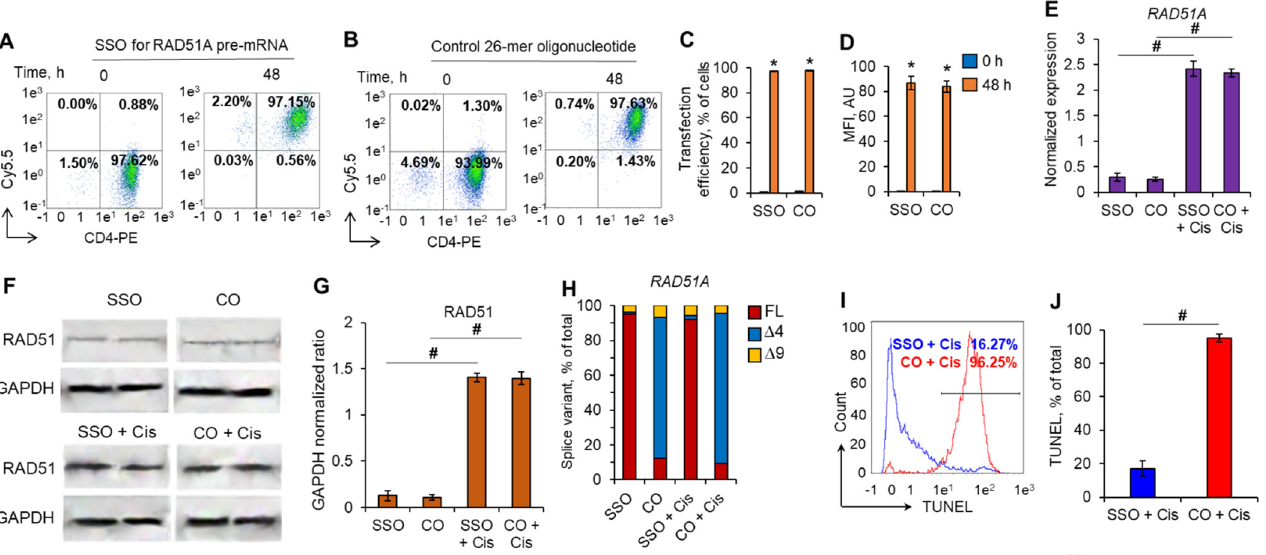
Figure 7. Modulation of RAD51A alternative splicing results in CD4 + T cell protection against cis- platin-induced apoptosis. Transfection efficiency of CD4 + T cells. Representative flow cytometry plots of cells transfected with Cy5.5-labeled ( A ) SSO for RAD51A or ( B ) a control 26-mer oligonu- cleotide 72 h posttransfection. ( C ) Efficiency of transfection. ( D ) Mean fluorescence intensity (MFI) of Cy5.5-positive cells. ( E ) mRNA levels of RAD51A measured by real-time RT-PCR in transfected CD4 + T lymphocytes incubated with cisplatin. mRNA levels were normalized relative to the expres- sion of the reference gene 18S. ( F ) Western blotting for RAD51 protein and the reference protein GAPDH in transfected cells incubated with cisplatin. ( G ) Results of RAD51 protein quantification relative to GAPDH. ( H ) mRNA levels of RAD51A splice variants measured by real-time RT-PCR in CD4 + T cells. ( I ) Representative TUNEL flow cytometry diagrams for cells transfected with oligonu- cleotides and incubated with cisplatin. ( J ) Results of TUNEL assay for flow cytometry. ( K ) Repre- sentative flow cytometry plots for cells labeled with annexin V-FITC and propidium iodide after transfection with oligonucleotides and incubation with cisplatin. The proportions of live cells (low